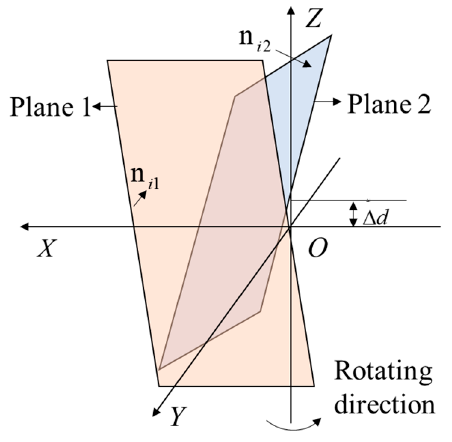
Figure 2. Measurement coordinates.